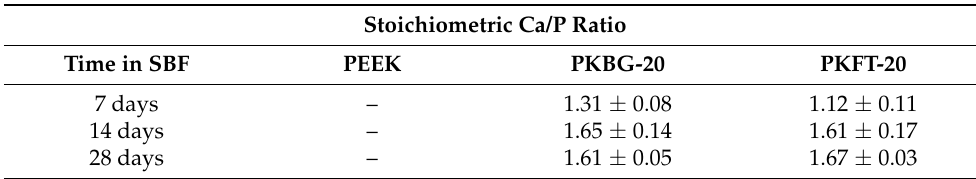
Table 3. Ca/P ratio (mean ± SD) on the surface of pure PEEK and PEEK-based nanocomposites, as determined by EDX